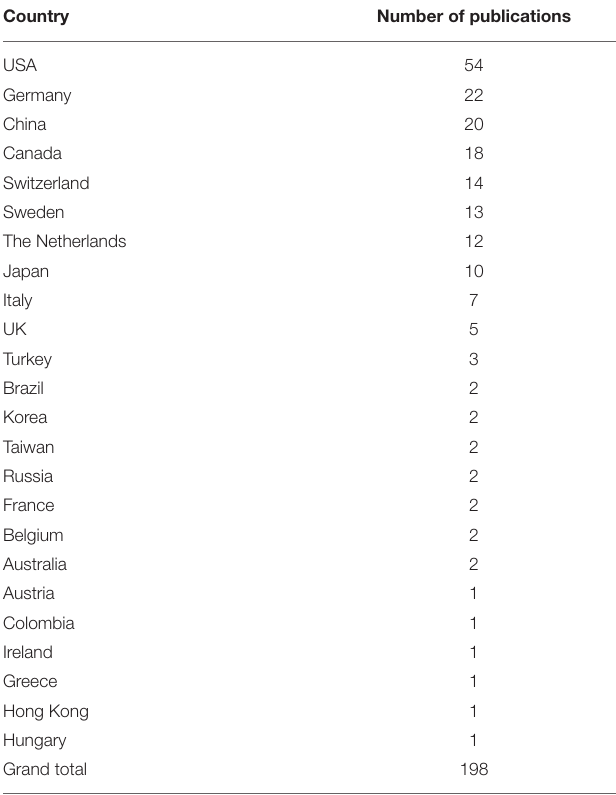
TABLE 2 | Number of publications that could be retrieved from the search as grouped by the country of publication.